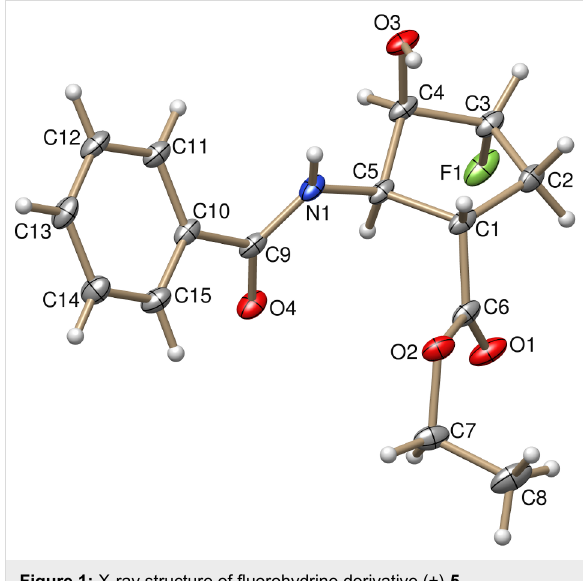
Figure 1: X-ray structure of fluorohydrine derivative (±)- 5